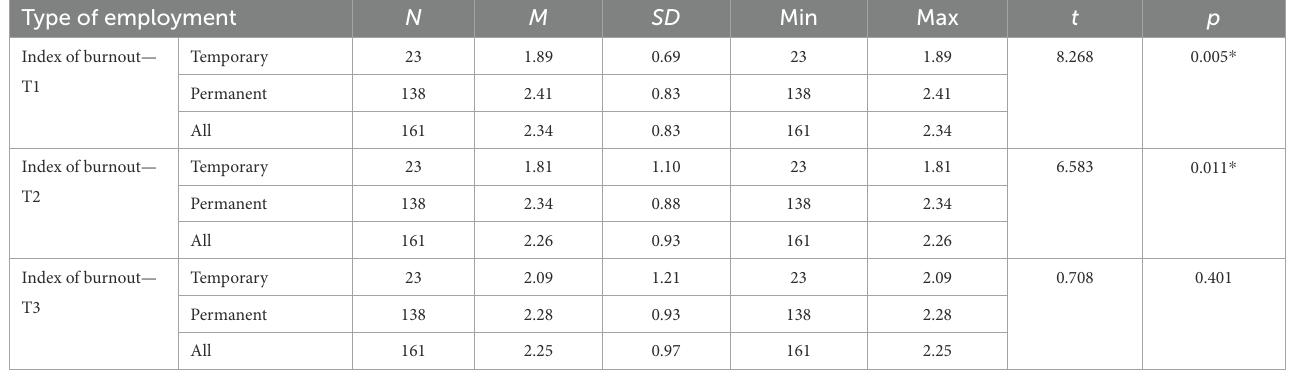
TABLE 6 Descriptive statistics and averages of burnout index comparison between teachers with permanent and temporary position at three time points. Type of employment N